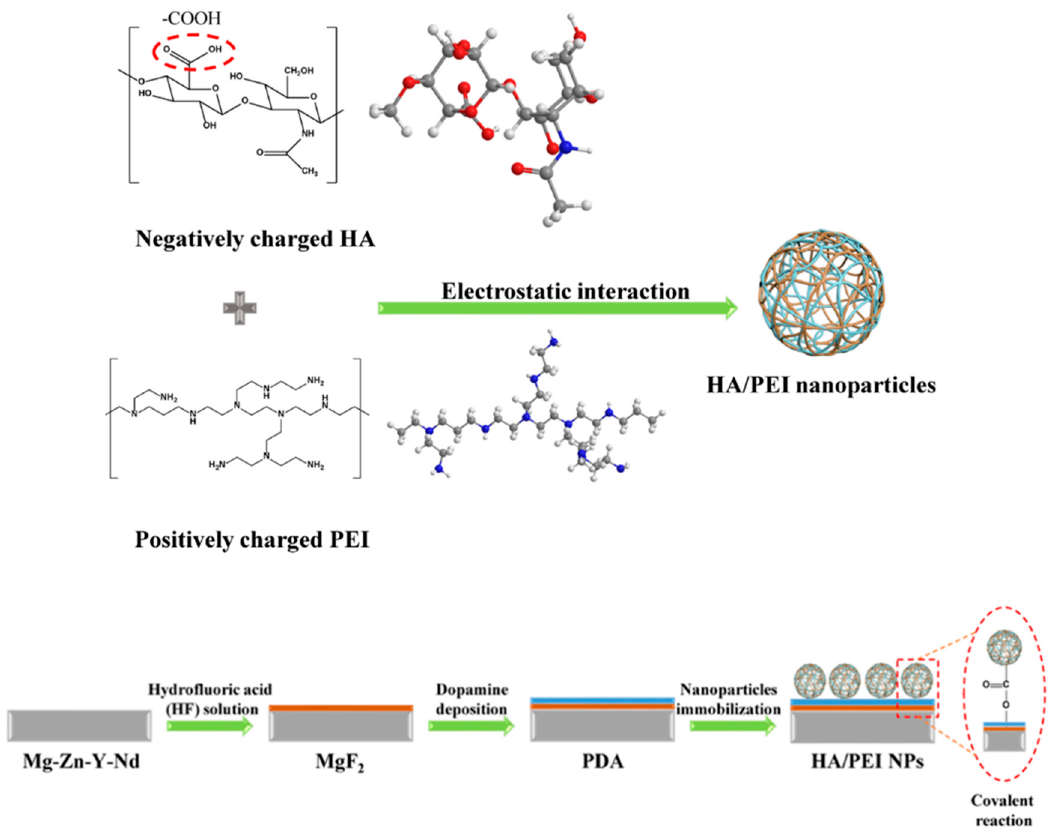
Figure 5. Mg alloy degradation products that regulate macrophages and EC behaviors [104].